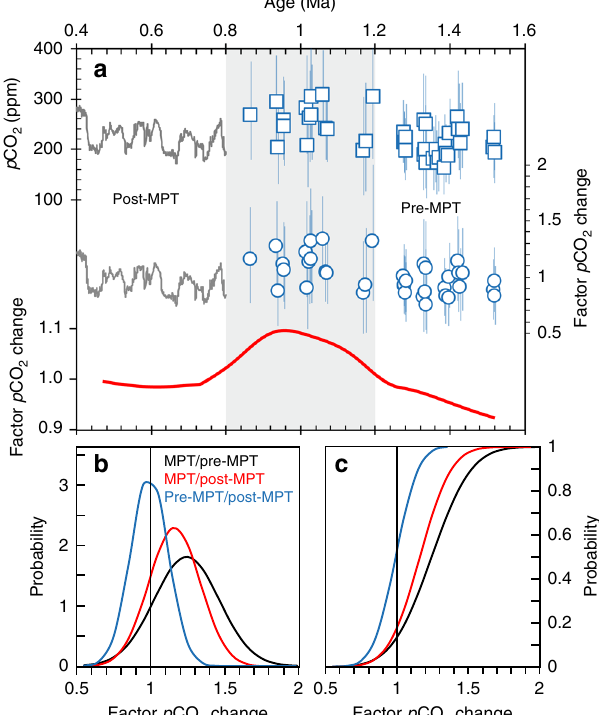
Fig. 4 p CO 2 and factor changes of p CO 2 during 1.6 – 0.4 Ma. a Interglacial paleosol- p CO 2 estimates from this study (blue squares), ice core p CO 2 data 36 (gray curves), and their factor changes (blue circles). Error bars represent 1 σ uncertainties. The three time periods (i.e. pre-mid-Pleistocene transition (MPT), MPT, and post-MPT) are shown separately, with the MPT highlighted by the gray bar. The locally weighted polynomial regression (LOESS) trend line (red curve) is based on 0.3 smoothing. b and c Probabilities of interglacial CO 2 change. The probability density functions (PDFs) and cumulative distribution functions (CDFs) show the probabilities of the factor changes in CO 2 among the three time periods